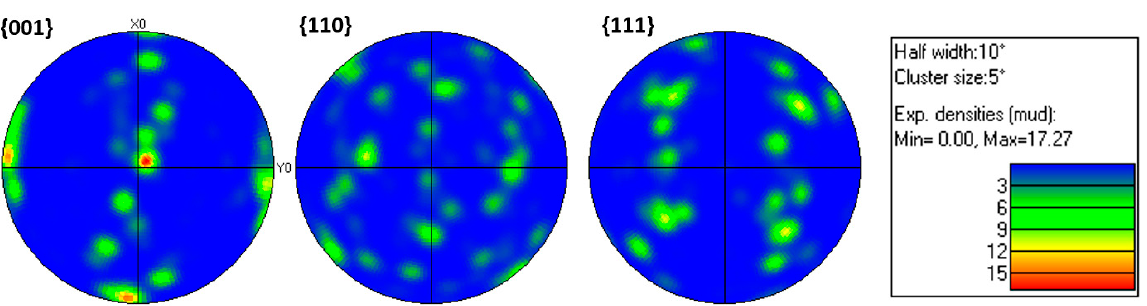
Figure 7. Pole figures of the brazed layer region of specimen S2 (1050 °C for 2 min).